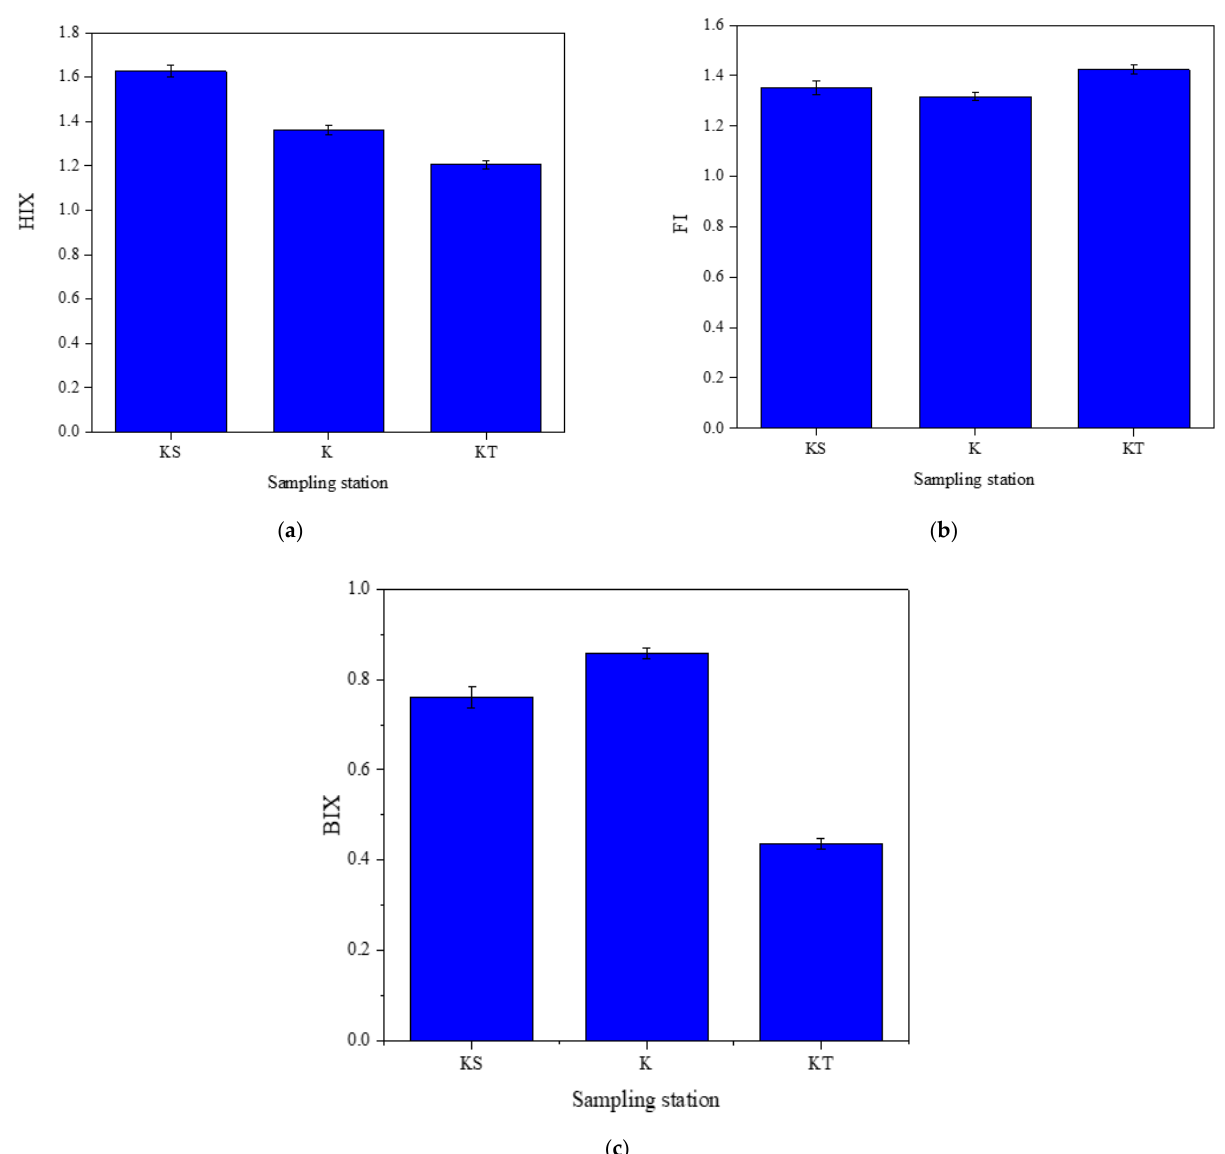
Figure 5. Fluorescent spectral indices of DOM in this study. ( a ) HIX ( b ) FI ( c ) BIX. Notably, FI can be used to differentiate between allochthonous and autochthonous DOM sources as well as data on the source of DOM. FI is an indicator of DOM source with higher (~1.4) and lower (~1.2) values indicating the microbial and terrestrial sources, respectively [4]. It was found that FI values for all three samples were in a range of 0.95 to 1.58, in which the lowest value was in DOM-KS, corresponding to the terrestrial input (allochthonous). By contrast, the FI value for DOM-KT is 1.58 and this